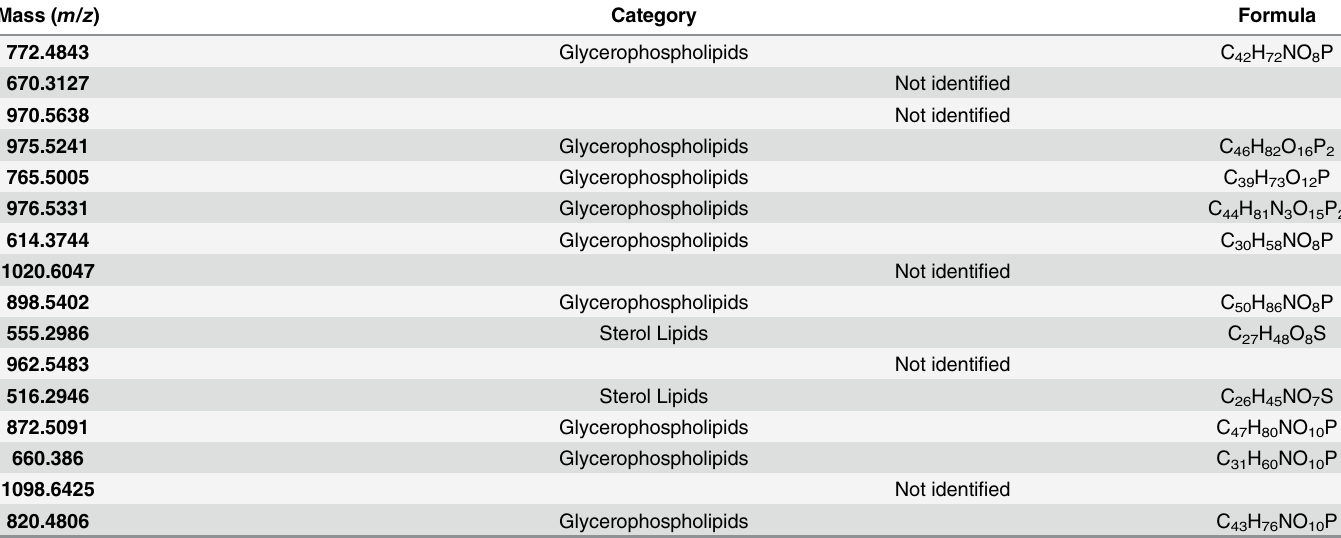
Table 3. Identified VIPs